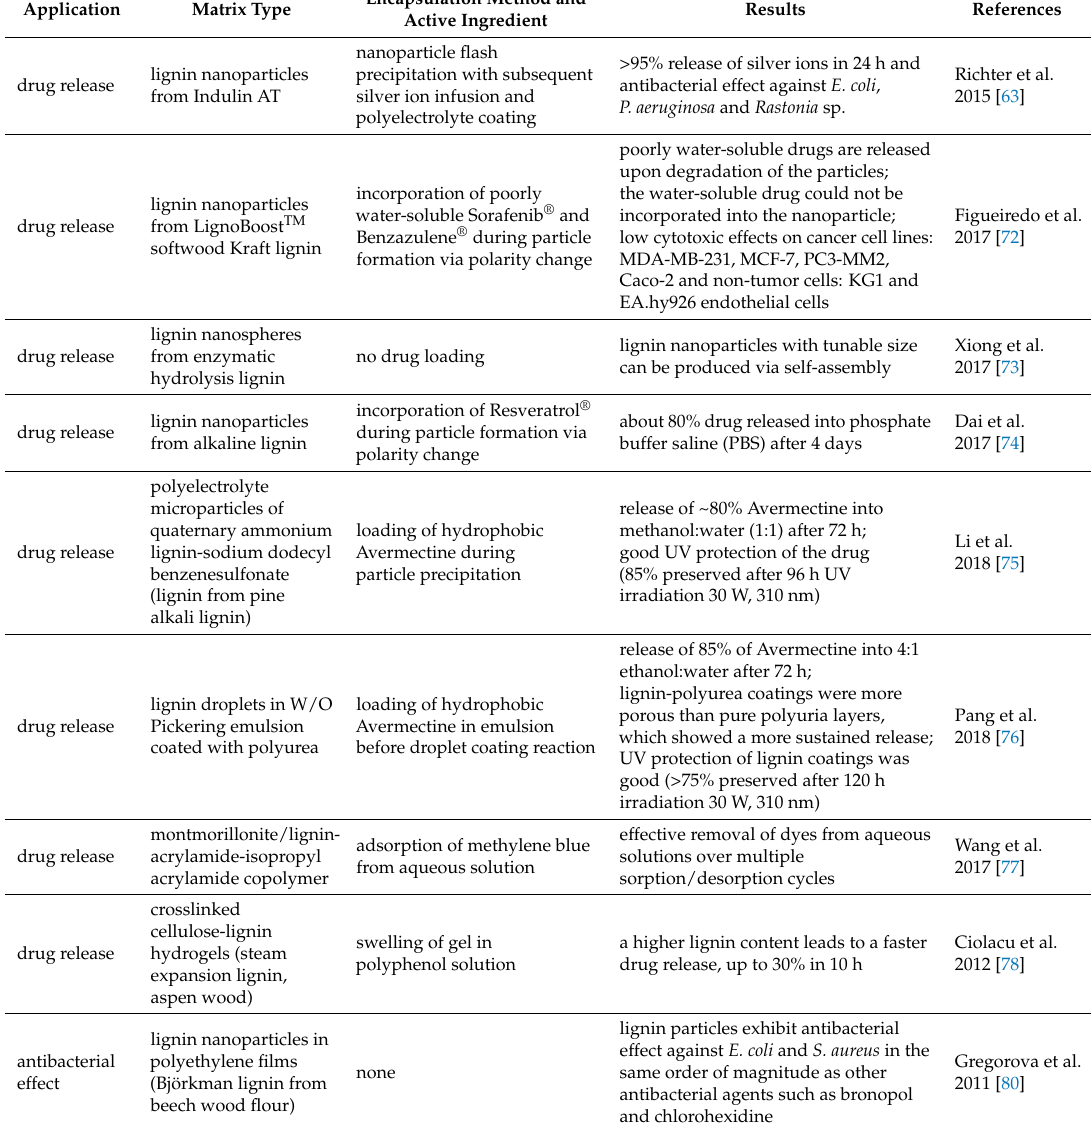
Table 3. Lignin-derived systems for biomedical applications: drug release and antibacterial